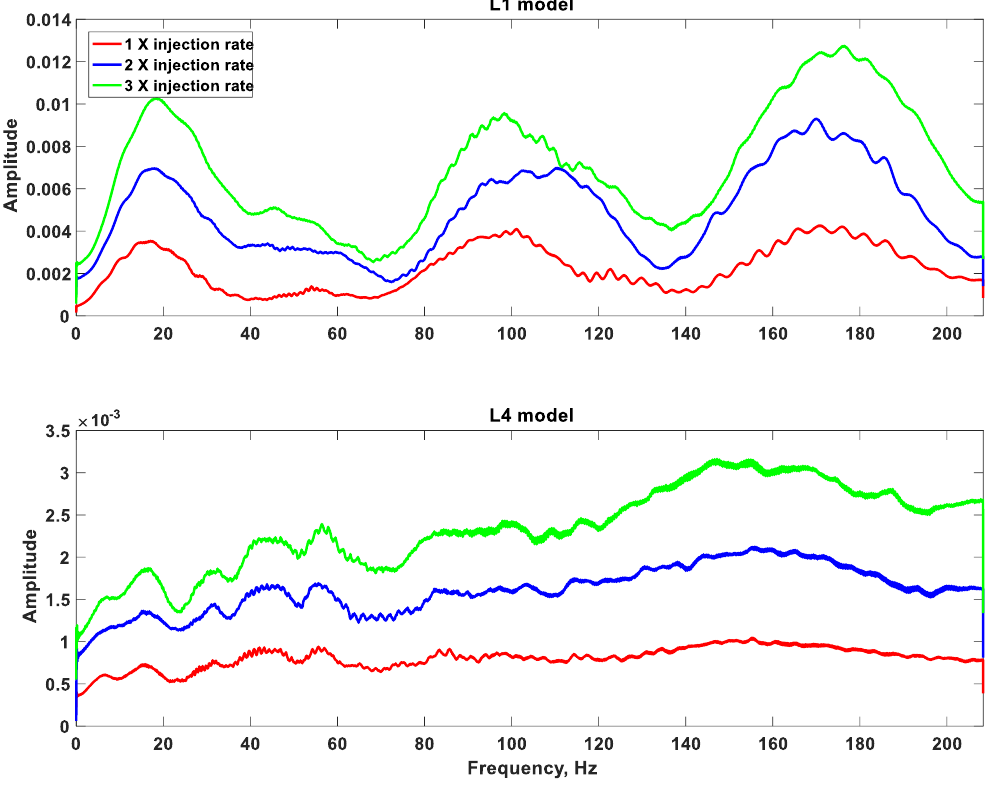
Figure 11—Comparison of the spectrums of the microseismicity induced in the models with different injection